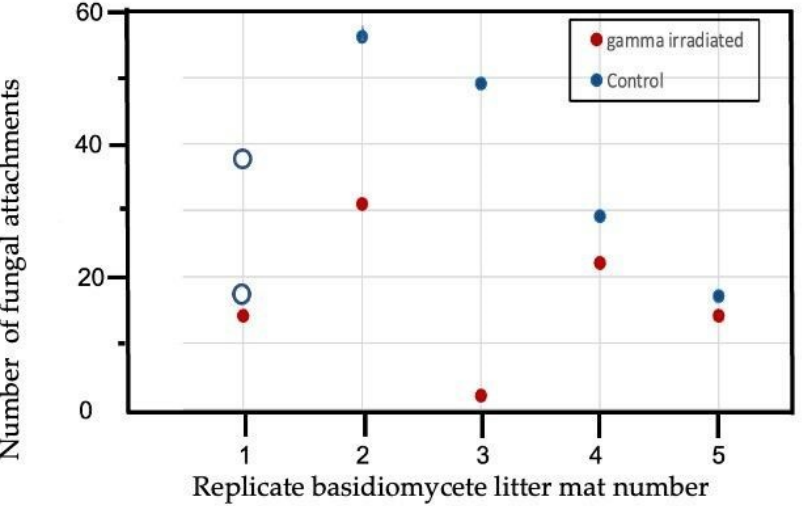
Figure 3. Number of non-unit-restricted basidiomycete attachments to leaves after 6 weeks incubation on Gymnopus johnstonii white-rot leaf litter mats in non-preconditioned leaves of Manilkara bidentata following gamma irradiation versus non-irradiated controls. Number of attachments for the control litter on mat 1 was missing data so a sensitivity analysis was run on the Wilcoxon’s Signed Ranks test using two different estimates of fungal attachments, shown with open circles: 17, the number observed for mat 5 which had similarly low (3–5%) percent white-rot, and 38, which is the mean number of attachments for leaves on the other 4 litter mats.